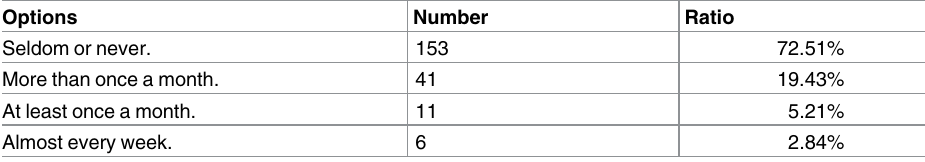
Table 3. How often will you clean up your followees/friends?